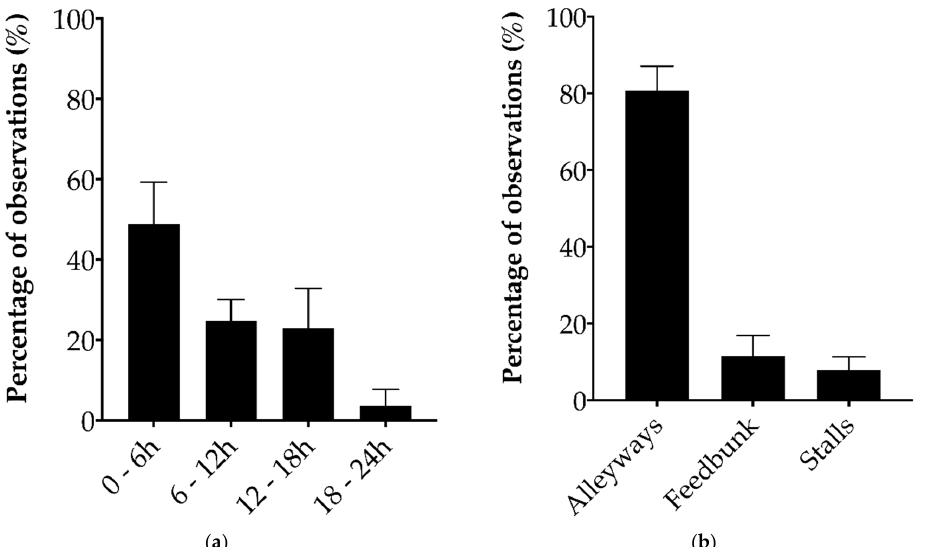
Figure 1. Percentage (mean ± SD) of agonistic behaviors initiated and received by dairy heifers during the first 24 h of a regrouping event (n = 30) in relation to: ( a ) four 6-h periods, ( b ) the location within the pen where the agonistic behavior was observed.